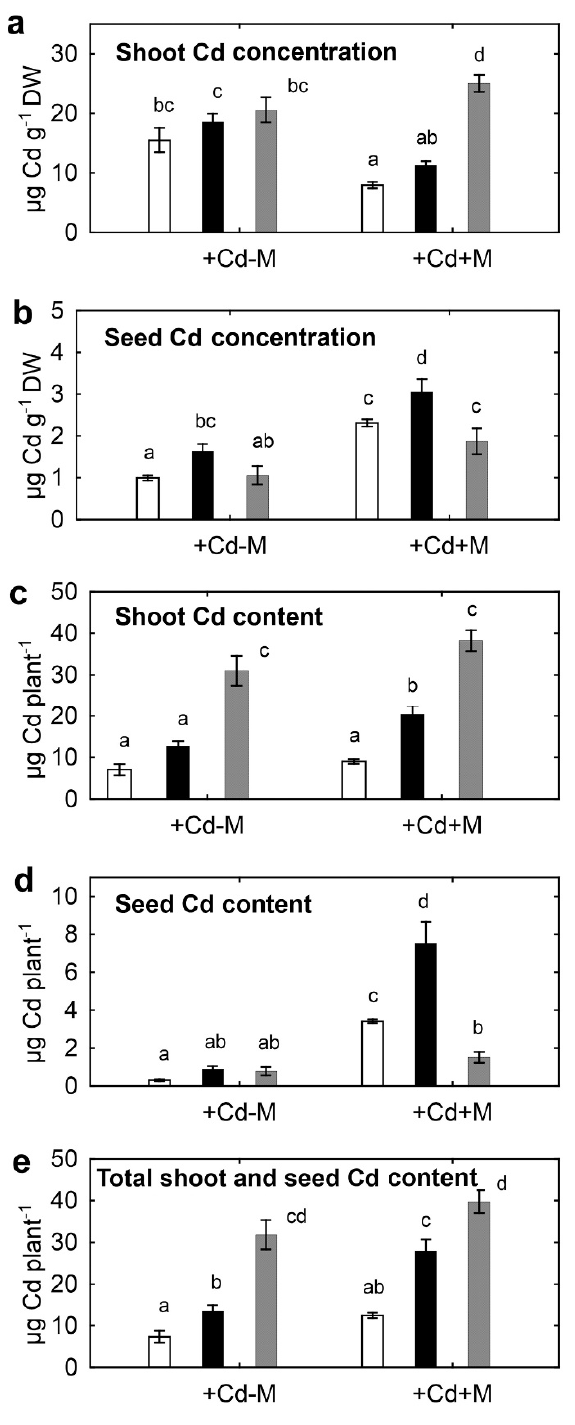
Figure 3. Cadmium concentration in shoot ( a ) and seeds ( b ), and Cd content in shoot ( c ), seeds ( d ) and aerial part ( e ) of pea SGE (unfilled columns), SGECd t (filled columns) and B. juncea (gray columns) grown in Cd-supplemented soil. Treatments: +Cd-M—Cd-supplemented soil with uninoculated plants, +Cd+M—Cd-supplemented soil with inoculated plants. Plants were inoculated with a microbial consortium consisting of Variovorax paradoxus 5C-2, Rhizobium leguminosarum bv. viciae RCAM1066, and Glomus sp. 1Fo. Vertical bars show standard errors. Different letters show significant differences between treatments (least significant difference test, p < 0.05, n = 5). DW stands for dry weight. Plants were analyzed on the 83rd day after planting.